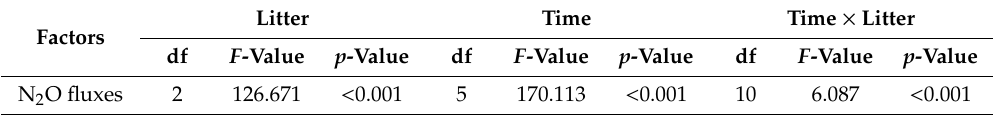
Table A3. Results of two-way repeated-measures ANOVA concerning the e ff ects of sampling time, litter manipulation, and the interaction between sampling time and litter manipulation on the N 2 O fluxes of the Larix gmelinii